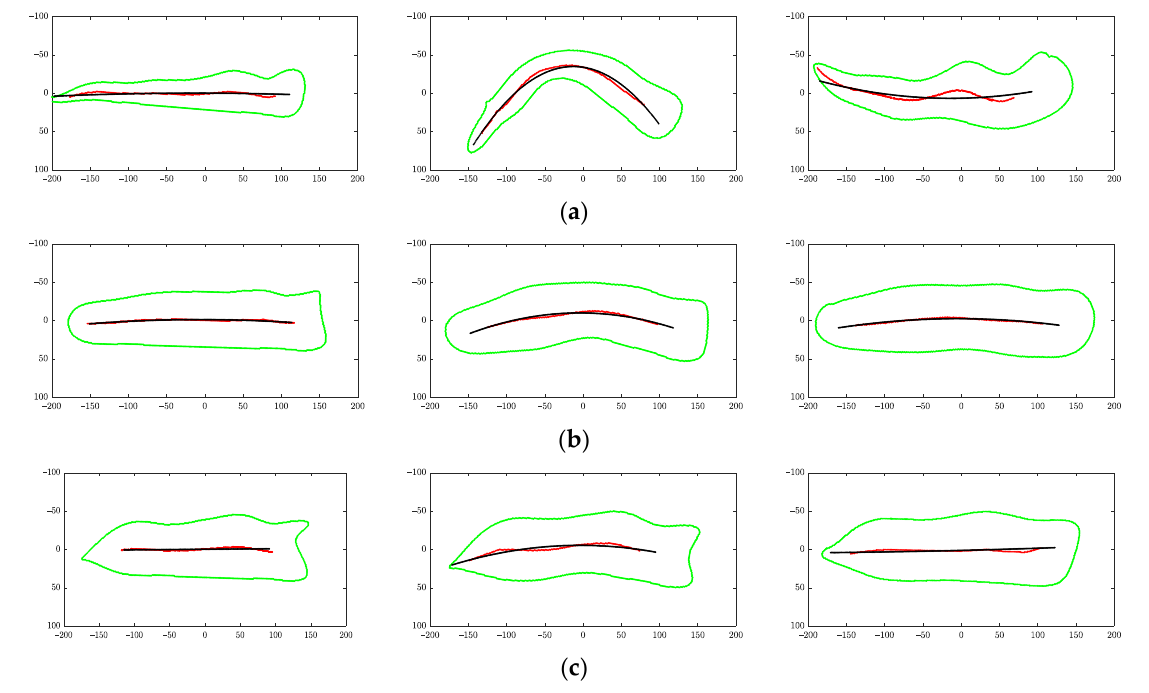
Figure 9. Objects to compute bending energy from regressed skeletons of ( a ) normal, ( b ) moderate WB, and ( c ) severe WB fillets. Raw skeletons are red, while regressed skeletons are black. Table 1. Instrumental measurements of physical features of fresh broiler breast